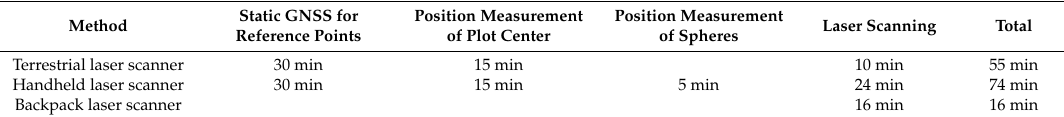
Table 7. The different working tasks and time consumption per plot for each laser based